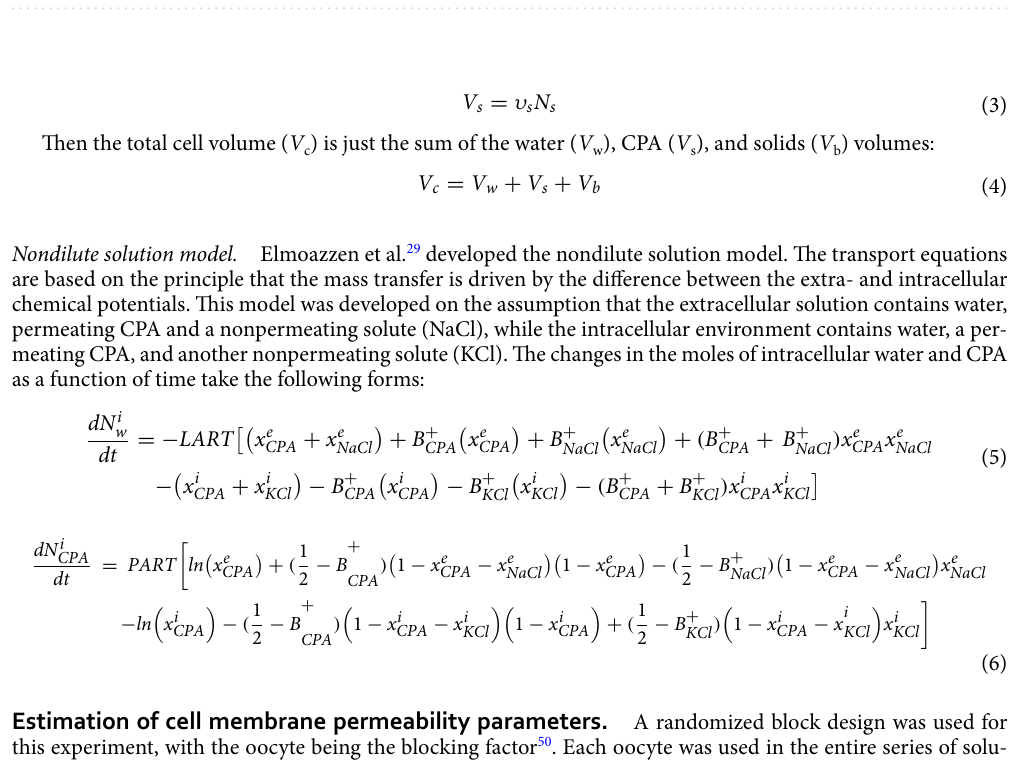
Table 4. CPA concentration. CPA cryoprotectant, EG ethylene glycol, Me 2 SO dimethyl